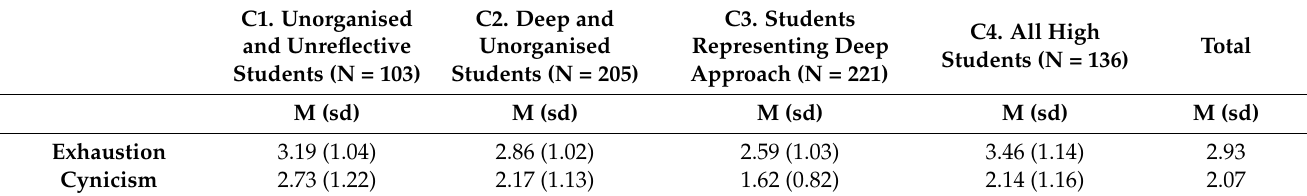
Table 3. Differences in exhaustion and cynicism, according to the profiles, during normal situations.